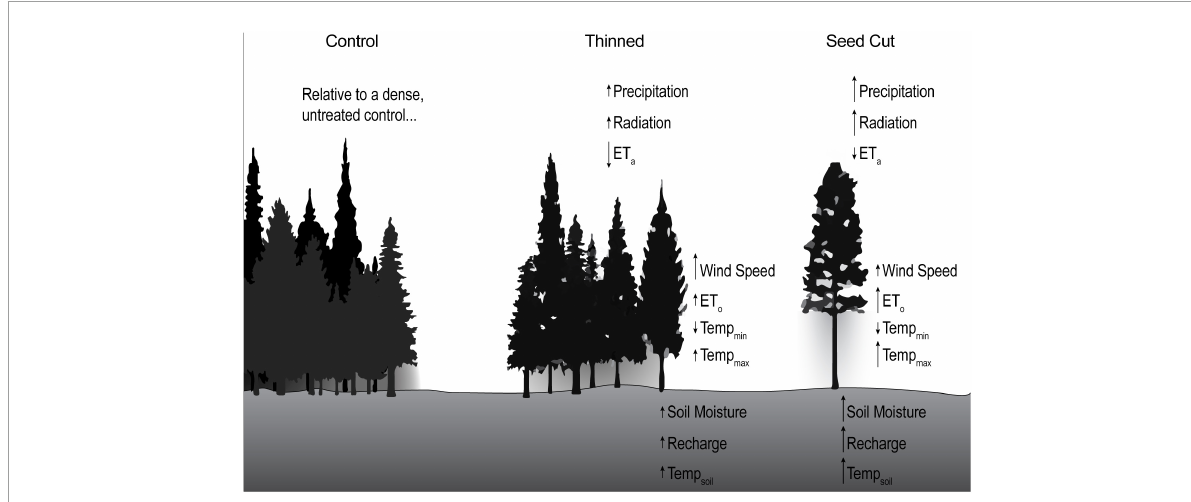
FIGURE1 Conceptual diagram of the relative change in water balance components in treated stands compared to a dense, untreated forest. The untreated forest serves as the Control, and the treated stands include a modestly and uniformly thinned forest (Thinned) and nearly-cleared forest patch with sparse seed trees (Seed Cut). Arrows indicate change in direction and magnitude of parameters relative to the Control, as observed in this study, except for actual evapotranspiration (ET a ), precipitation, and recharge which were not measured and are based on expected behavior. As thinning intensifies, ET a is expected to decrease (fewer trees transpiring) and recharge is expected to increase (more precipitation reaching the forest floor). In contrast, reference evapotranspiration (ET o ) at 2 m above the forest floor may increase due to increased shortwave radiation and wind reaching the ground. Treatments also affect minimum (Temp min ) and maximum (Temp max ) air temperature, and the greatest change was observed in minimum temperatures at nighttime. Soil temperature similarly increased (Temp soil ) in the Thinned and Seed Cut treatments where fewer trees shaded the